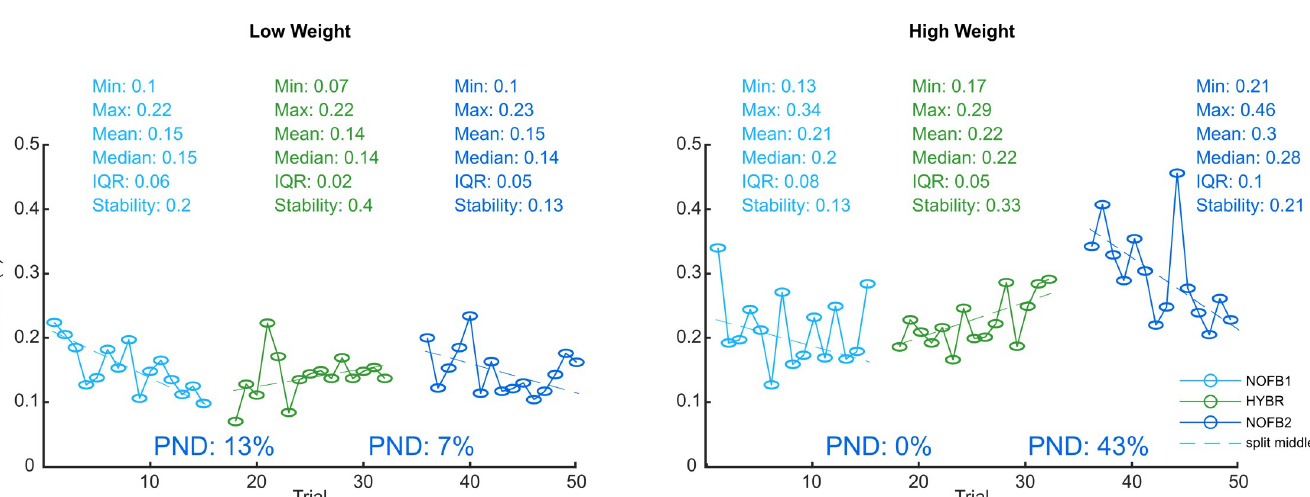
PLOS ONE | https://doi.org/10.1371/journal.pone.0256753 September 1,